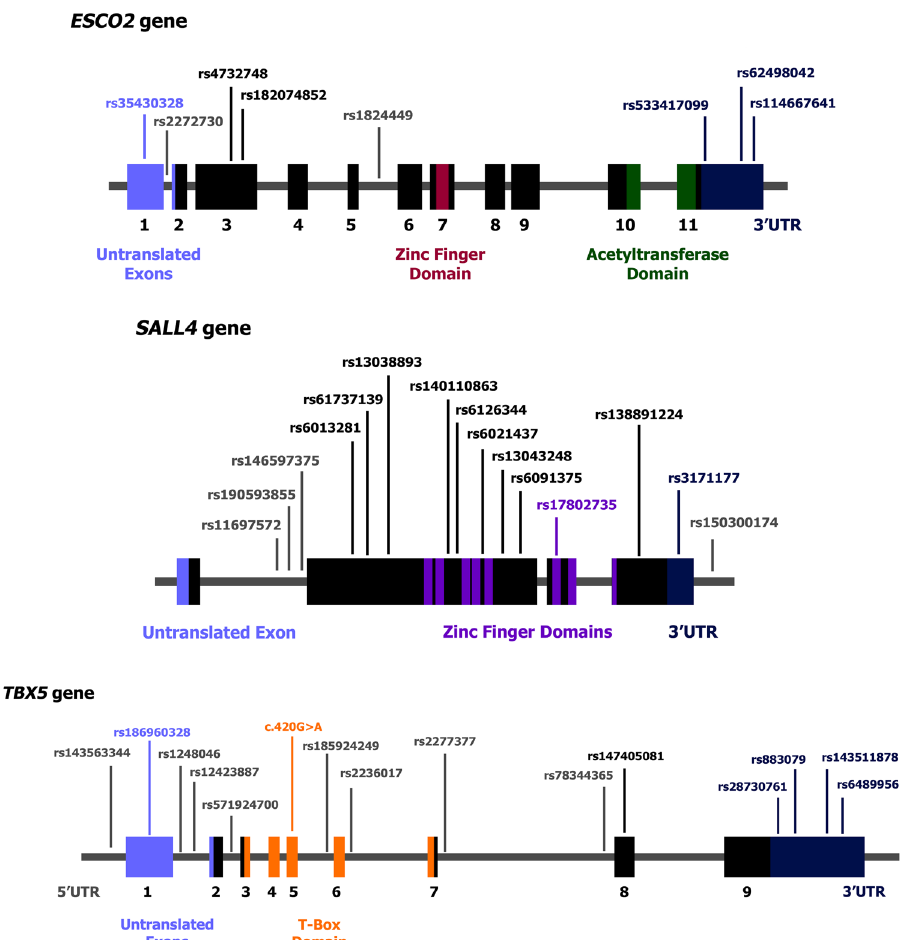
Figure 1. Position of variants found in exons, flanking introns and untranslated regions of ESCO2 , SALL4 and TBX5 genes in people with Thalidomide Embryopathy. We identified 8 variants in ESCO2 gene, 15 in SALL4 gene and 15 in TBX5 gene (one of them – c.420 C > T (p. Asp140 = ) – a novel